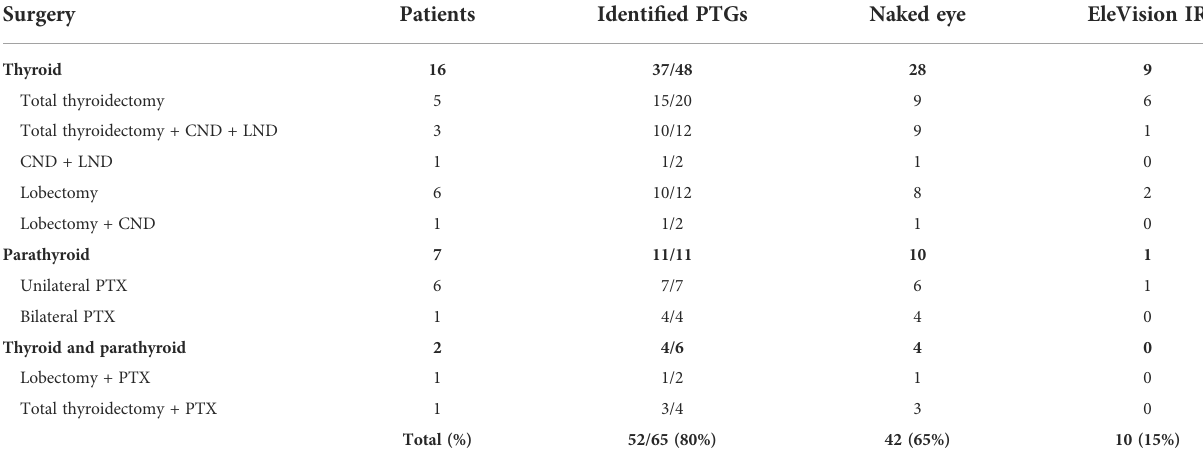
TABLE 3 Number of parathyroid glands identi fi ed with the naked eye only and the EleVision IR system during thyroid and parathyroid surgery. Surgery